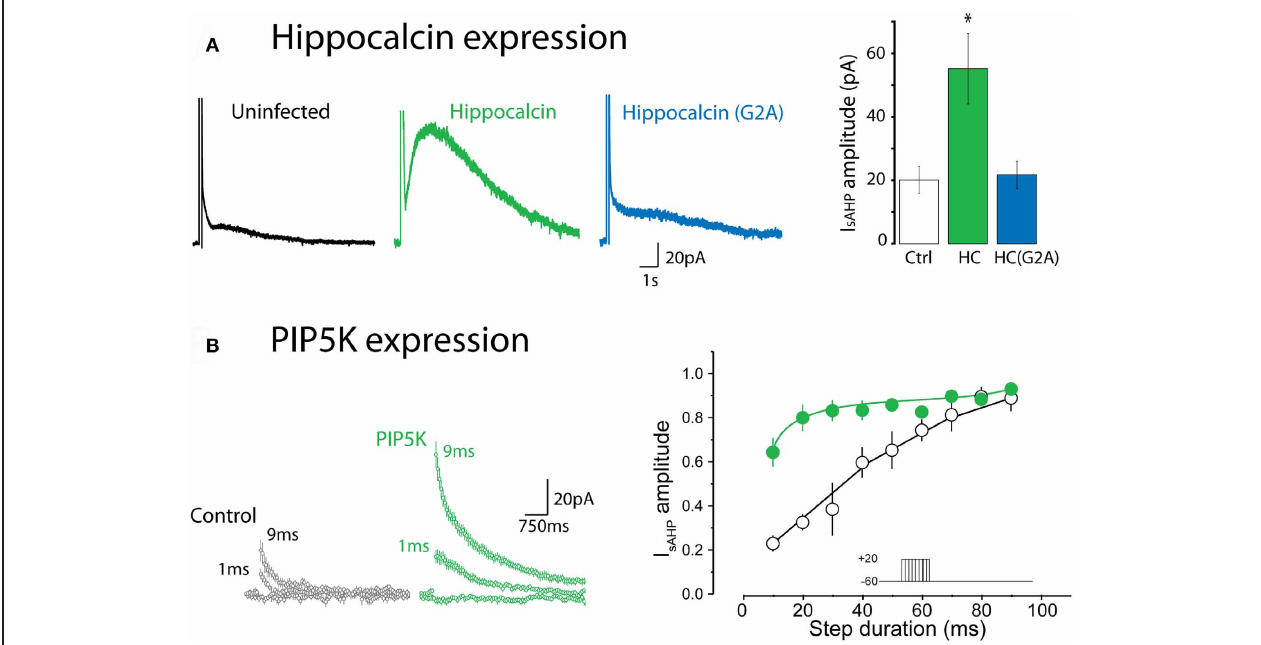
Tzingounis et al. (2007). (B) Expression of PIP5K enhances the apparent ability of calcium to elicit I sAHP . In this experiment calcium influx was titrated using depolarizing steps of increasing duration. Under control conditions I sAHP is activated in a graded manner by depolarizing steps ranging from 10 to 100ms. In contrast, in cells transfected with PIP5K I sAHP is activated by much shorter steps. Redrawn from data in Figure 7 of Villalobos et al.